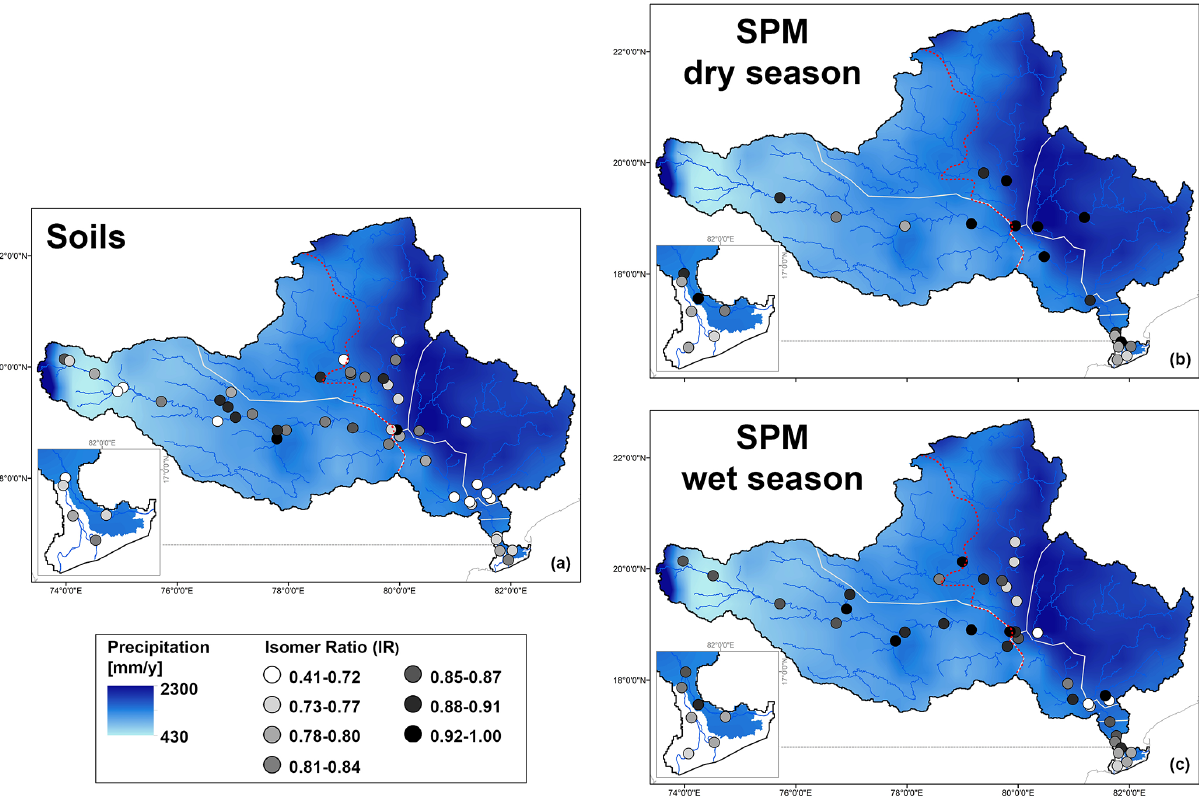
Figure 7. Maps showing the spatial distribution of IR values for (a) soils and SPM collected in the (b) dry and (c) wet season. The main panel shows the whole basin, with a zoom for the delta region. The points refer to the IR values, and the long-term average rainfall distribution is shown in the